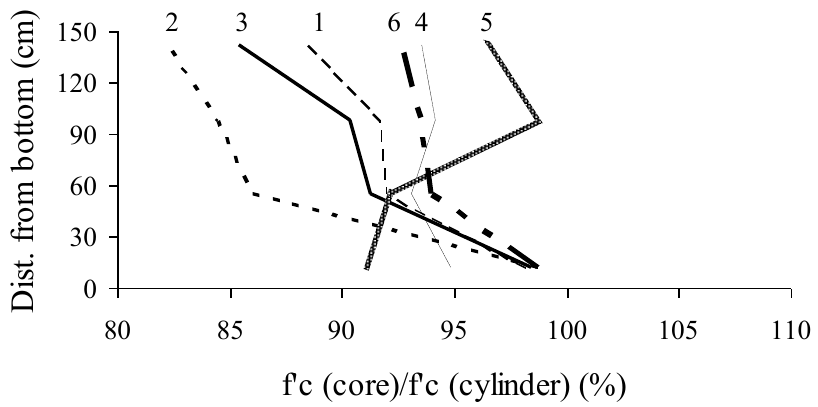
Figure 8. Variations in relative in-place compressive strengths with height (strength ratio relative to reference cylinder).